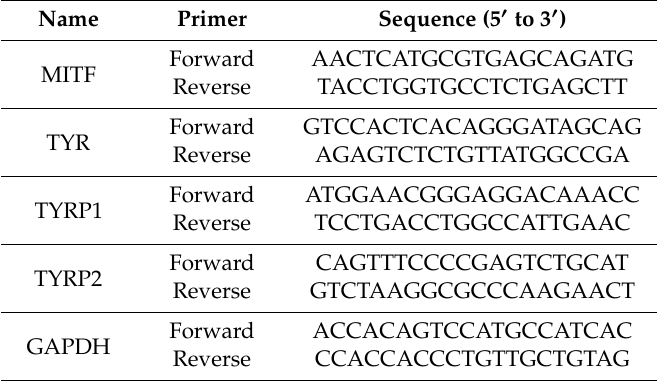
Table 1. Sequences of primers (mouse) used in semi-quantitative